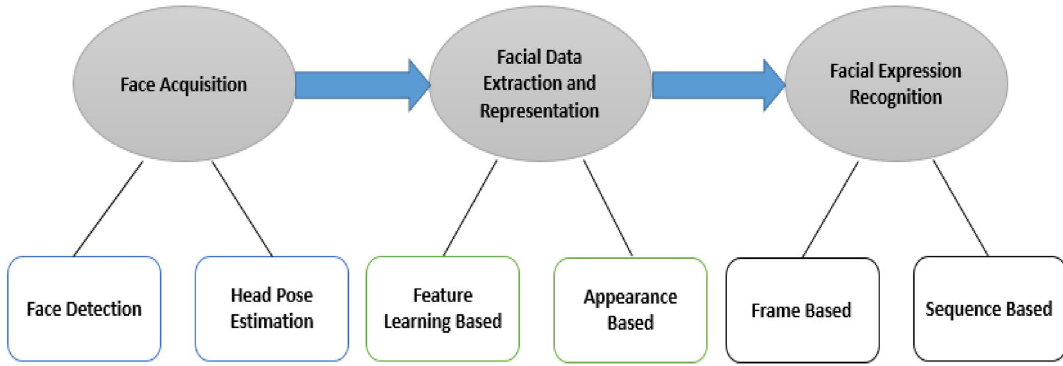
Figure 2. The basic framework of applications in many areas for automatic facial expression analysis.